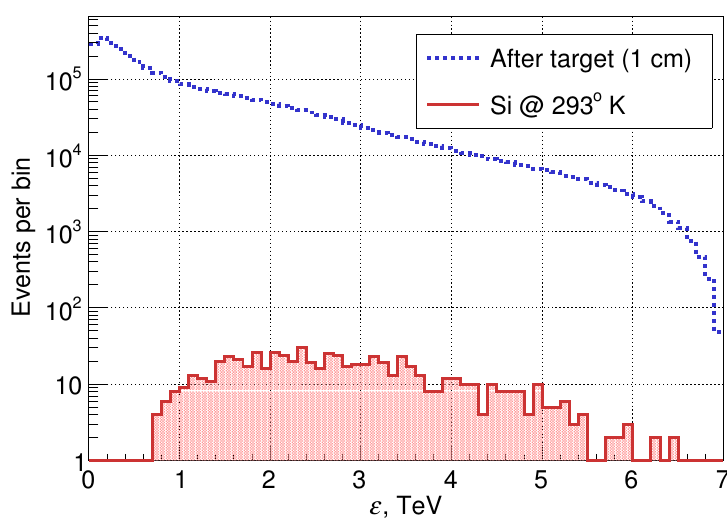
Figure 7 . The spectrum of reconstructed (cid:3) + 5 (cid:2) 10 8 s (cid:0) 1 . The dotted blue curve shows the spectra of (cid:3) + target-converter.The red histogram shows the spectrum of channeled (cid:3) + silicon crystal at room temperature with L crys = 8 cm and R = 22